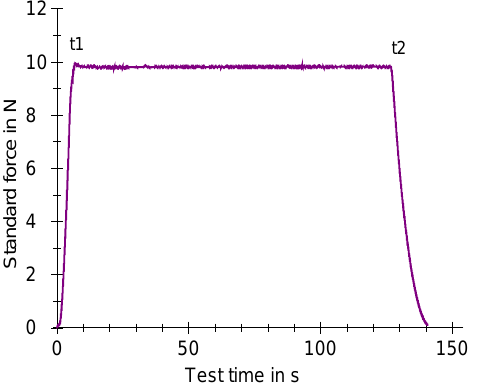
Figure 1. A tetragonal pulse where a standard force (F = 9.81 N) was applied for 120 s.